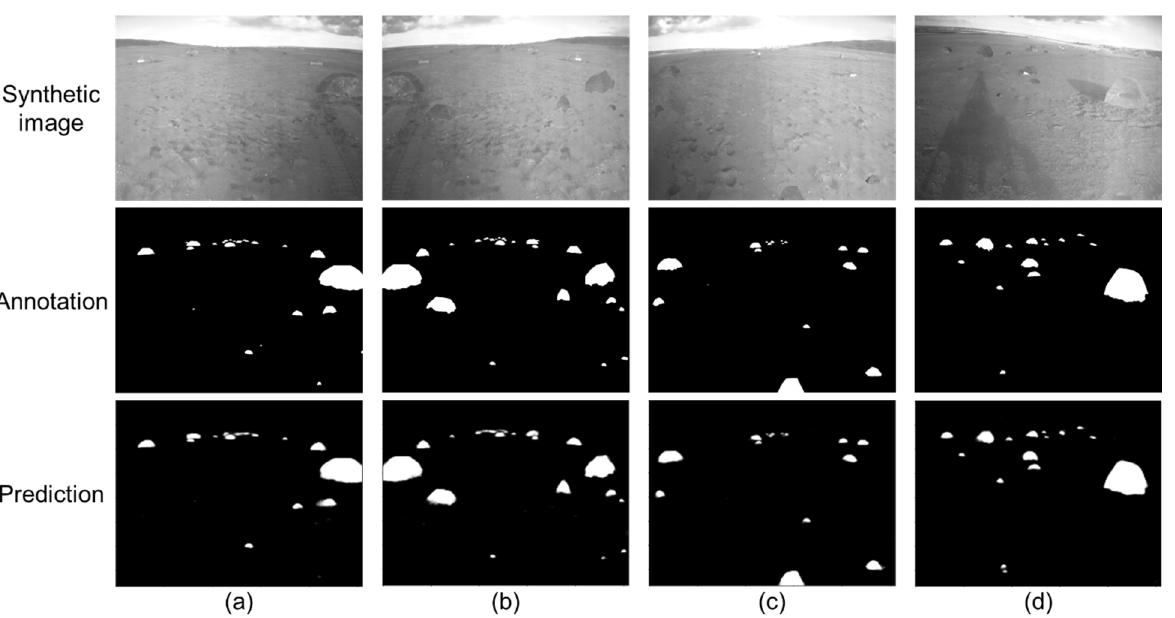
Figure 9. The example results of the NI-U-Net++ rock segmentation network in the pre-training process. “Synthetic image”, “Annotation”, and “Prediction” refer to the synthetic input images, the simultaneously generated ground truth annotations, and the predictions from the pre-trained NI-U-Net++, respectively. ( a – d ) correspond to four examples.